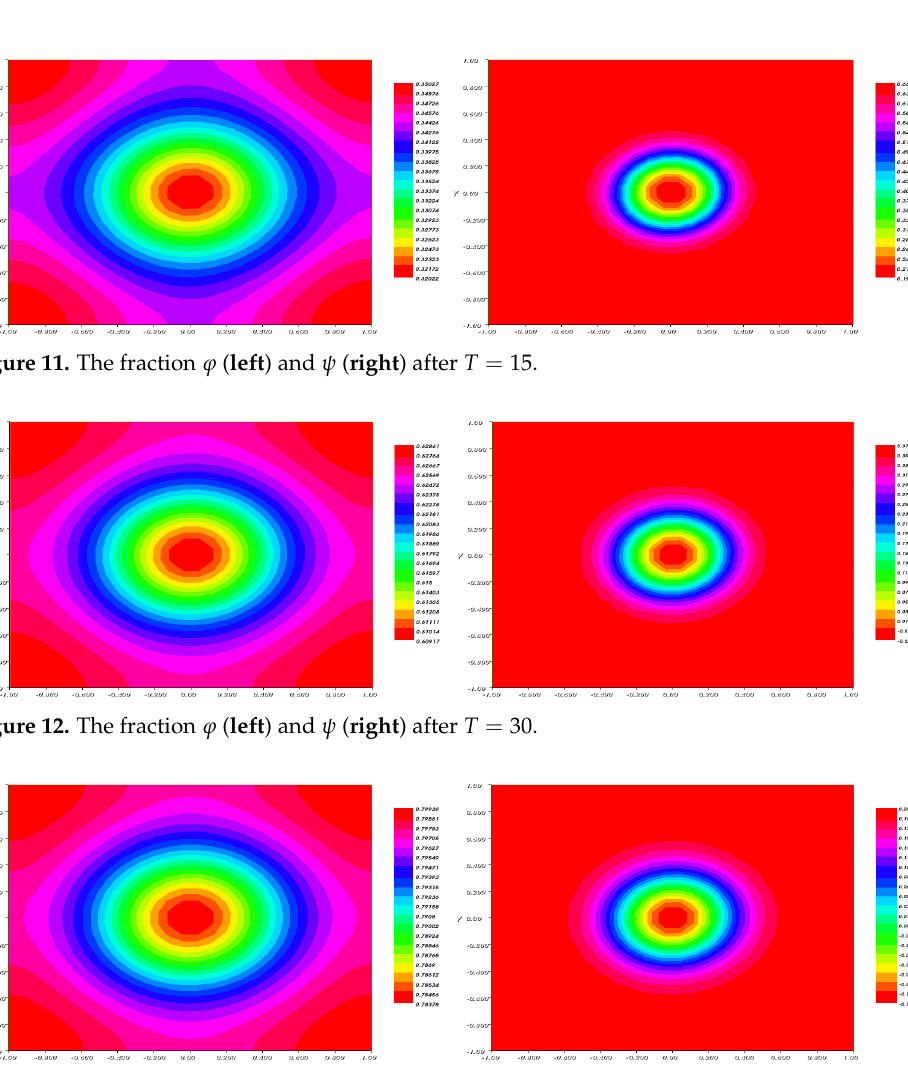
Figure 13. The fraction ϕ ( left ) and ψ ( right ) after T = 50.